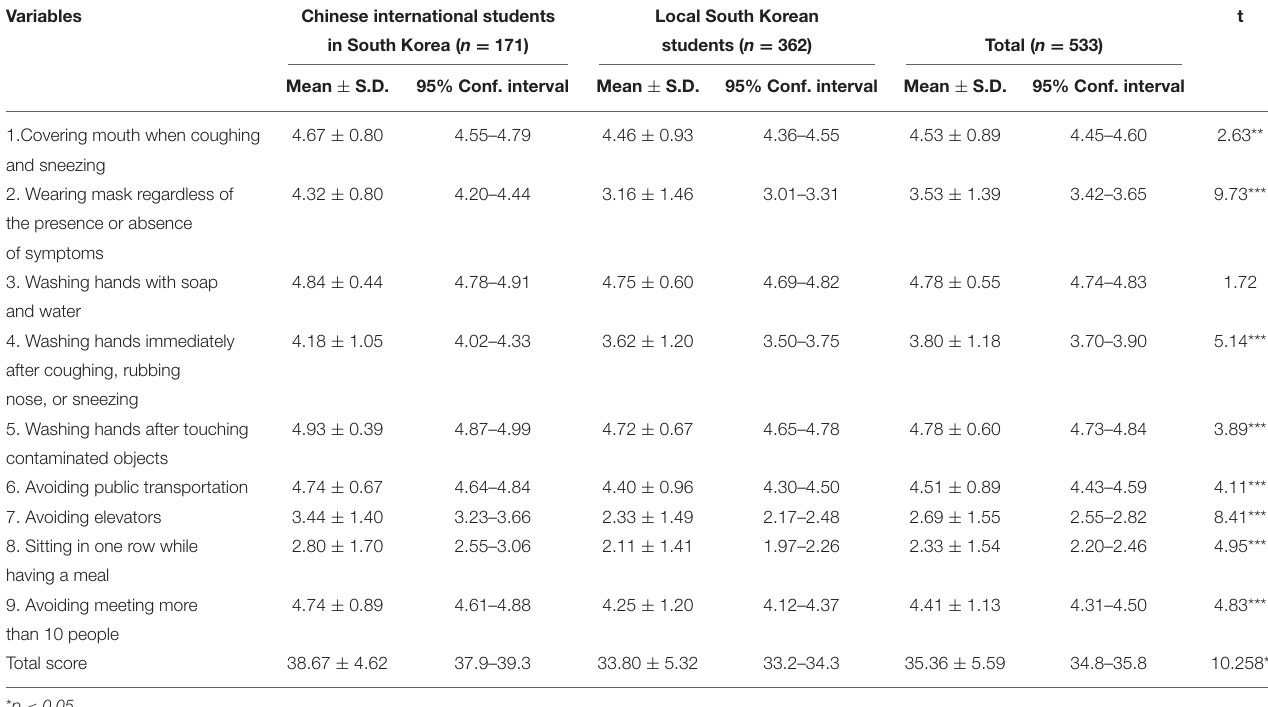
TABLE 3 | Preventive practices taken against COVID-19 (Mean ± S.D).